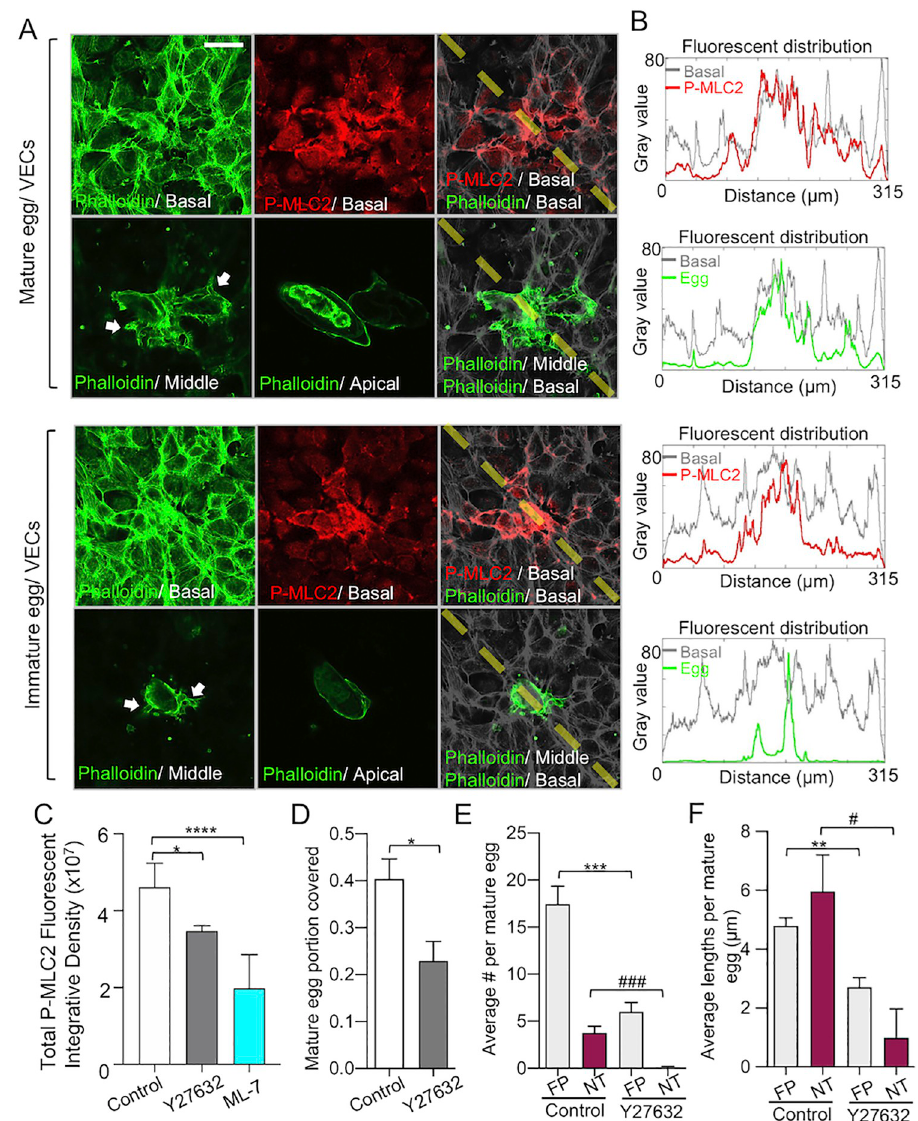
Fig 4. VEC contractility is involved in filopodia formation and encapsulation of eggs. (A) Immunostaining of phosphor-MLC2 and F-actin in VECs during encapsulation of live mature eggs at 4 h. The egg location is confirmed by different focal planes of VEC F-actin staining given that the eggshell is covered by VECs. The white arrows in the middle F-actin focal plane show the extended VECs surrounding the egg and indicate the corresponding egg location. (B) Fluorescent intensity analysis (the right panel) of phosphor-MLC2 basal (red line)/ F-actin basal (gray line) and F- actin middle (green line)/ F-actin basal (gray line) shows the distributions of phosphor-MLC2 and egg location across the merged images (yellow dashed line). Note how the induction of VEC myosin contractility localizes with the egg location (scale bar: 50 μ m). (C) Phosphor-MLC2 fluorescent integrative density (mean ± s.e.m.) after 4 h of egg-VEC interaction. VECs were pre-treated with DMSO (white), Y27632 (Rho/RCOCK pathway inhibitor; gray) and ML-7 (myosin light chain kinase inhibitor; blue) for 30 min before incubating with eggs. � and ���� , indicate p < 0.05 and p < 0.0001, respectively using a one-way ANOVA with Dunnett’s post-test. Six image fields from three independent experiments were analyzed. (D) Quantification of the mature egg portion covered by VECs (mean ± s.e.m.). � indicates p < 0.05 using Student’s t -test. (E) Quantification of the number (mean ± s.e.m.) of FPs and NT formed per mature egg. ��� indicates p < 0.001 and ### indicates p < 0.001 using Student’s t -test. (F) Quantification of the average lengths of FPs and NTs (mean ± s.e.m.). �� indicates p < 0.01 and # indicates p < 0.05 using Student’s t -test. For D – F , 16 and 11 eggs from three independent experiments were used for the control and Y-27632 treated VEC cases,